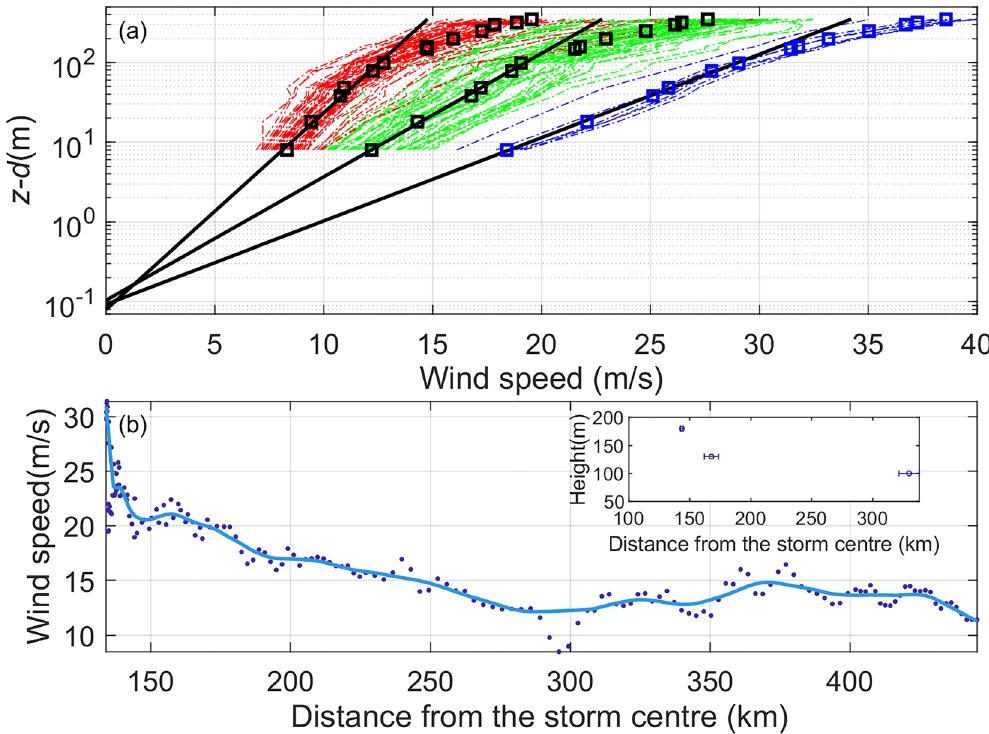
Figure 6. ( a ) Vertical profiles of 10-min average wind speed. Each symbol shows the mean value at a given vertical level. The 3 fitted lines are based on the data below 100 m using the least square method. The wind speed data are grouped according to 3 wind speed ranges: 5–10 m/s (red), 10–15 m/s (green) and 15–20 m/s (blue). ( b ) Multiple-level mean wind speed (dot) and the fitting line (solid blue line) as a function distance from the TC center. The subpanel in ( b ) shows the dependence of the logarithmic surface layer height on the distance from TC center. The horizontal bars indicate the standard deviations of the distances grouped into 3 bins according to the 10-m wind speed ranges, as in panel ( a ).